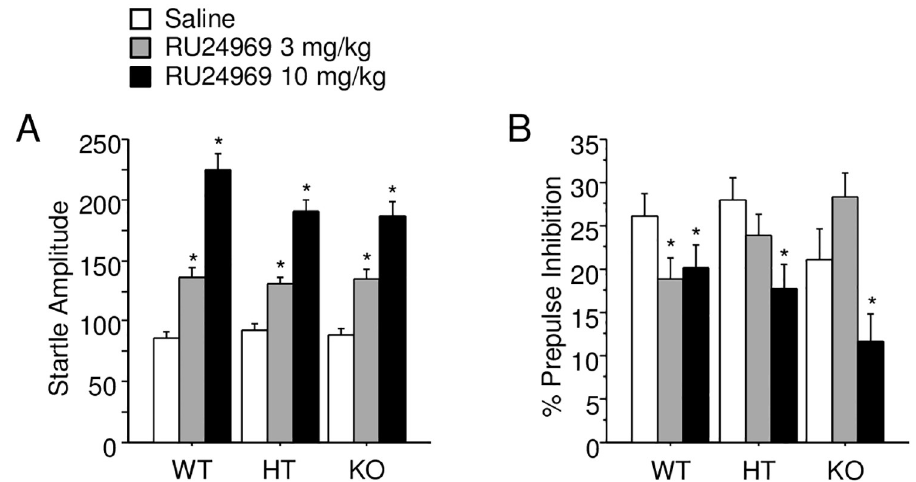
Fig 5. Reduced Arrb2 expression prevents 3 mg/kg RU24969-induced PPI deficits. A—B show startle amplitude (A) and PPI (B) for Experiment 5 (n = 13-15/sex/genotype), in which Arrb2 WT, HT, and KO, male and female mice were administered 0 (white bars), 3 (gray bars), or 10 mg/kg (black bars) RU24969 5 minutes prior to initiating behavioral testing. Results expressed as mean ± SEM. � Significant difference from saline treatment group within genotype. PPI: prepulse inhibition SEM: standard error of the mean WT: wild-type HT: heterozygous KO: knockout.